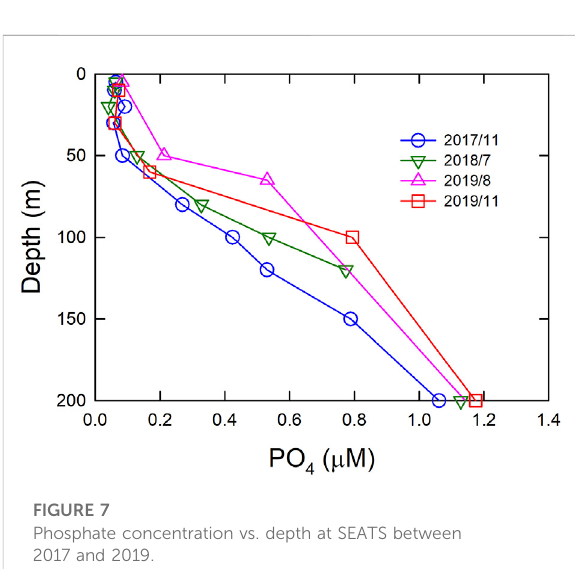
FIGURE 7 Phosphate concentration vs. depth at SEATS between 2017 and